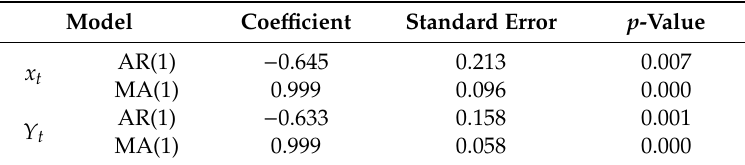
Table 2. Significance tests for the ARIMA model for T HH .